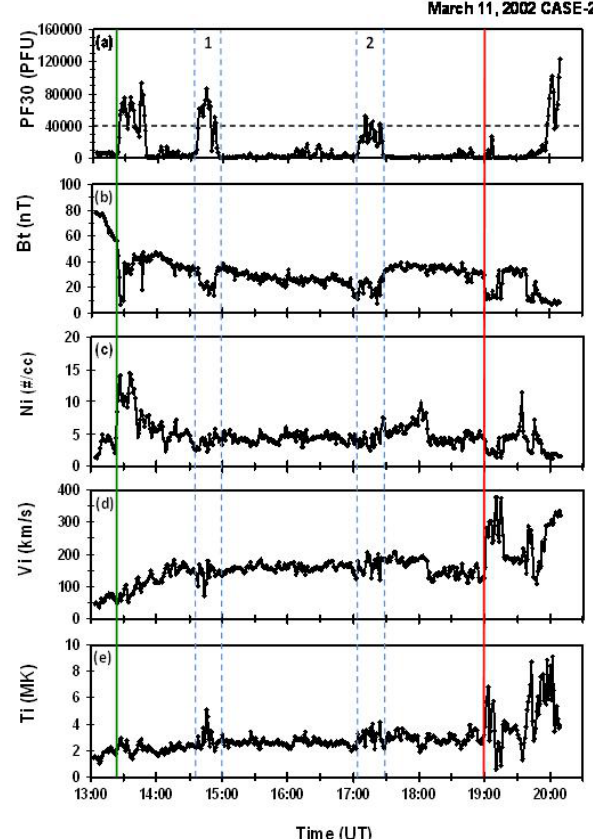
Fig. 11. From top to bottom, panels give particle flux (PF30), mag- netosheath magnetic field strength, density, speed, and temperature data versus time for 11 March 2002. Red and green lines denote the bow shock and magnetopause while blue lines show intervals of the burst events